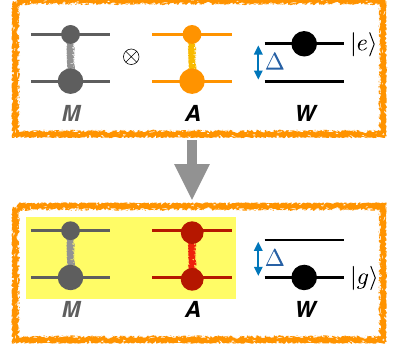
FIG. 2. Example of a work cost scenario without allowing correlations to build up. A qubit A , initially in equilibrium, is supposed to be heated up to an infinite temperature by spending some energy Δ and by using a (potentially large) catalytic system M that remains uncorrelated with AW (and unchanged by the process). A transition of this form is possible only at a work cost T . of at least Δ ⪆ 0 . 4 k B